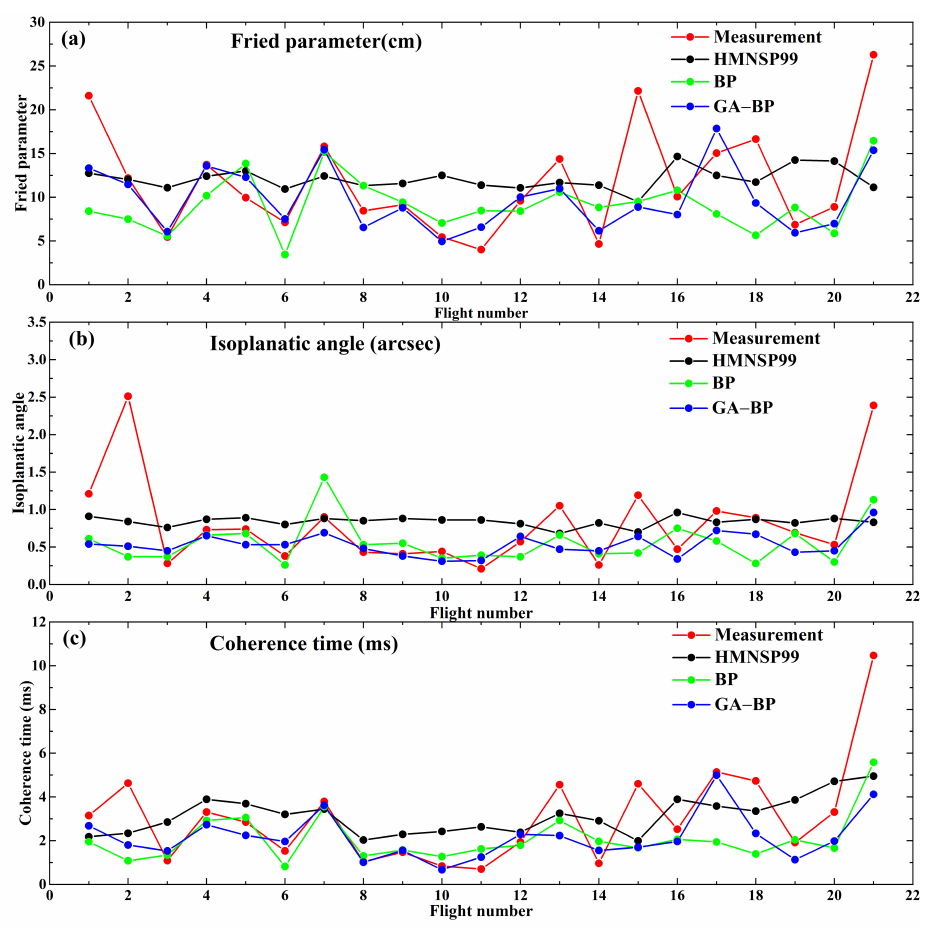
Figure 11. Comparison of the integrated parameters between GA-BP, BP and HMNSP99 models.